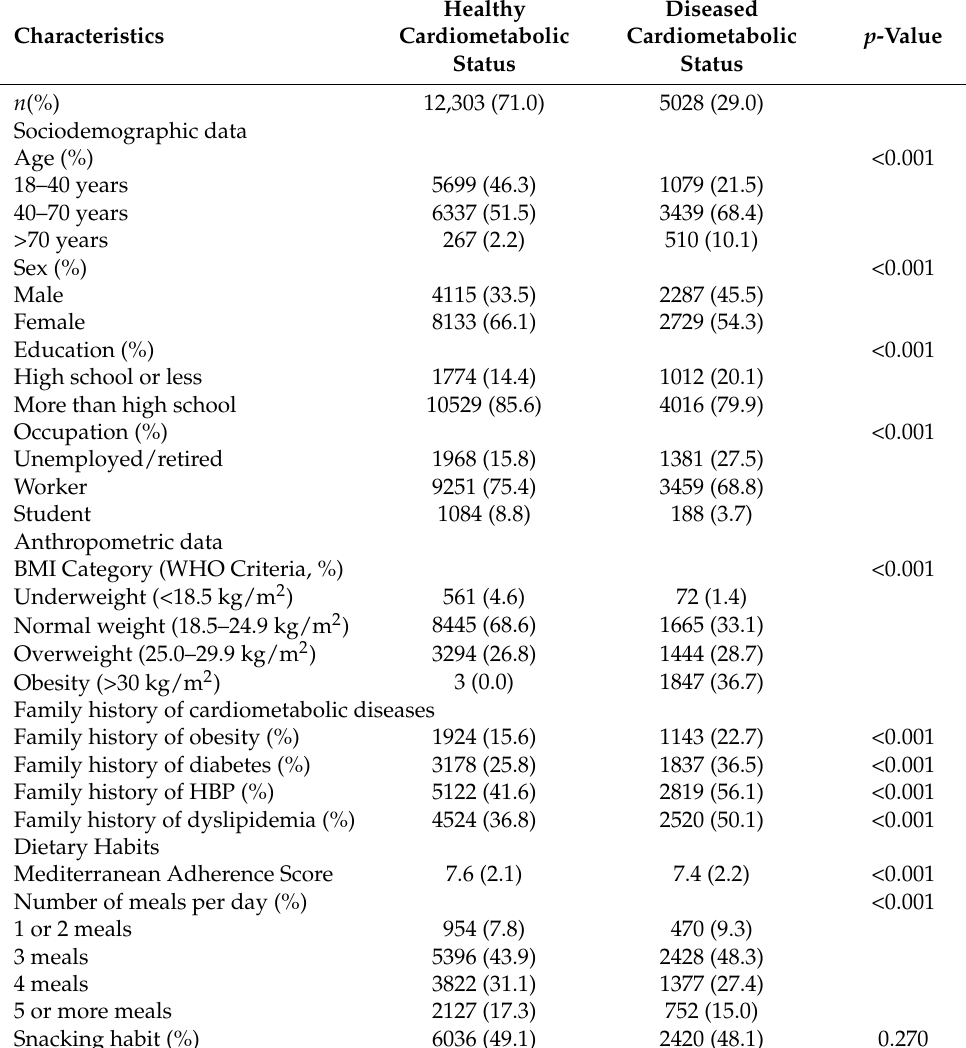
Table 2. Sociodemographic Data, Health Characteristics, Dietary Habits, Lifestyle and Quality of Life Features of the participants Categorized by Cardiometabolic Health Status (healthy/diseased). Characteristics